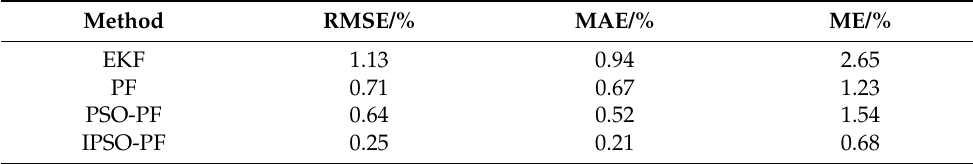
Table 5. Errors of FUDS Driving